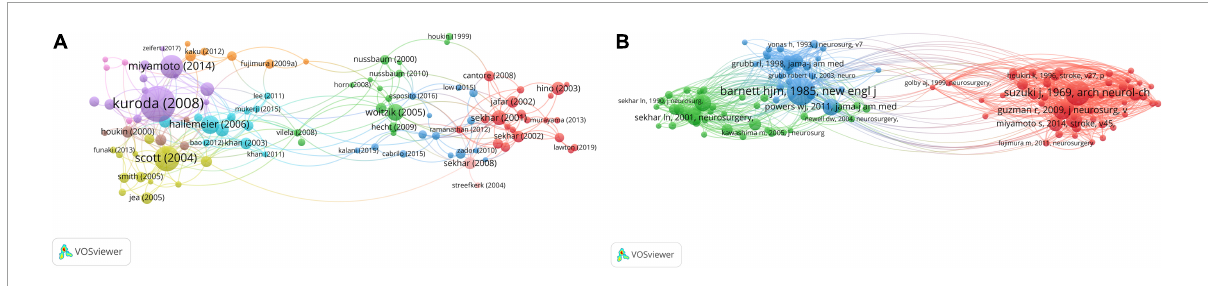
FIGURE9 Analysis of cited articles and co-cited references. (A) Network diagram of cited articles based on VOSviewer visual map. (B) Network diagram of co-cited references based on VOSviewer visual map. Different color clustering reflects the close relationship between cited articles and co-cited